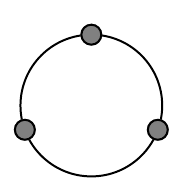
Figure 3 . Diagram in coordinate representation for the one loop corrections to the cubic